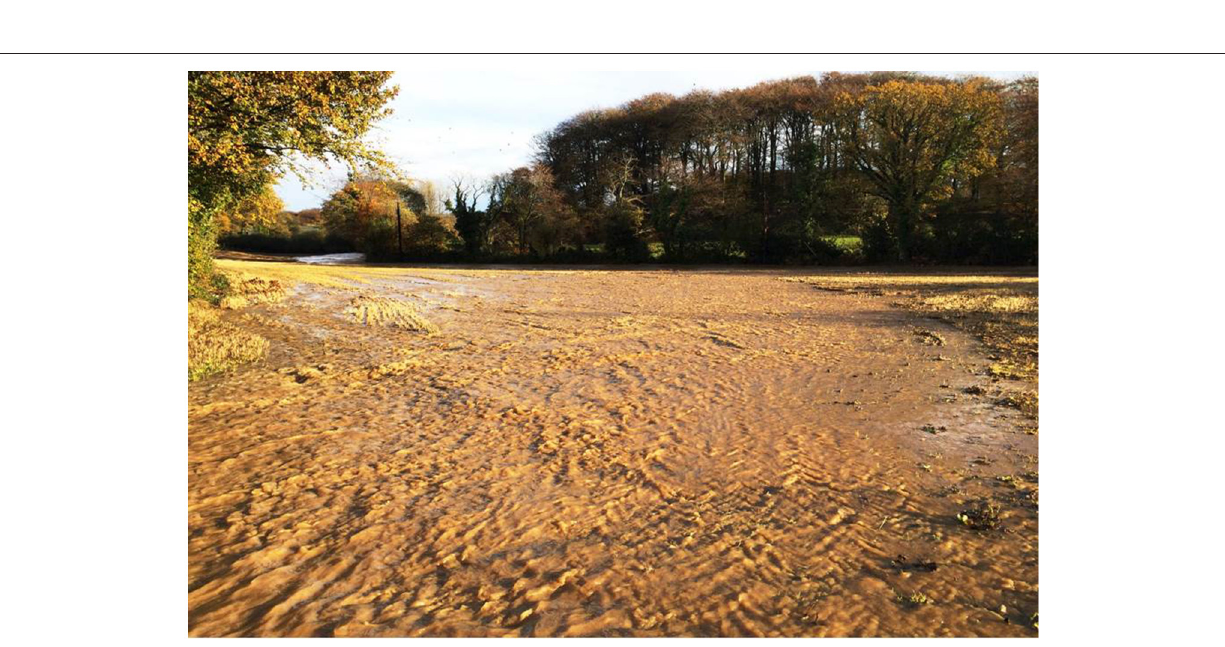
Frontiers in Marine Science |